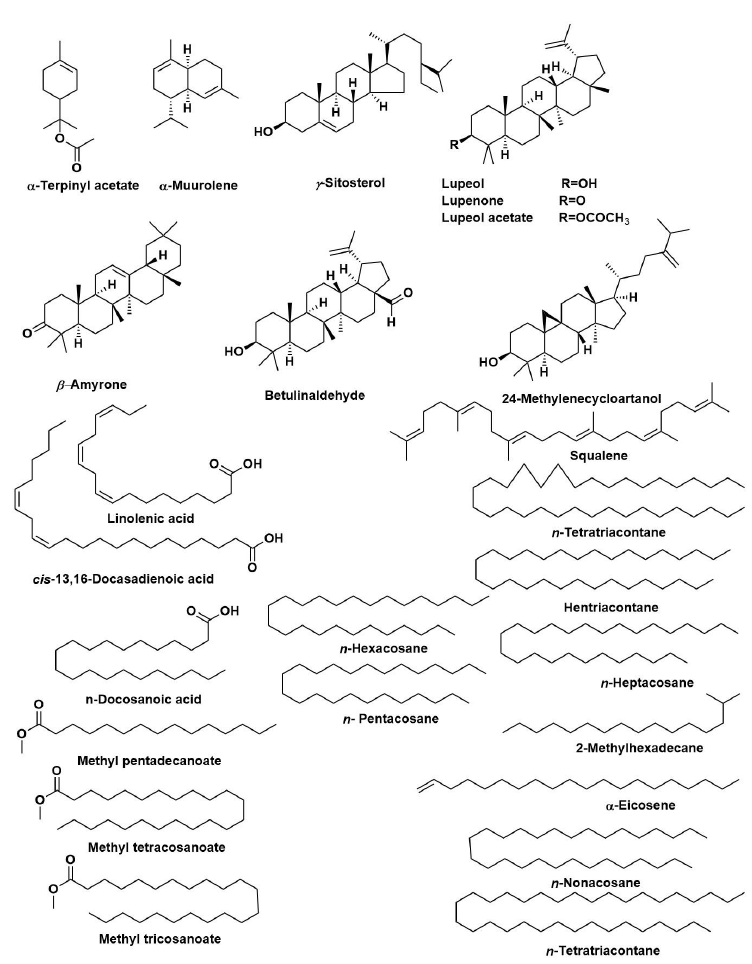
Figure 1. The major compounds identified in bark, leaves, seeds, and fruits of Tamarindus indica. Triterpenoids and steroids are the predominant classes in the T. indica bark n -hexane extract, accounting for 61.06 % and 13.47%, respectively. Additionally, the n -hexane ex- tract of T. indica leaves showed a high percentage of triterpenoids and steroids, represent- ing 47.41% and 11.86% of the identified compounds, respectively, along with fatty acids and their derivatives accounting for 8.40 %. On the other hand, the most predominant classes of metabolites in the n -hexane extract of T. indica seeds were fatty acids and their derivatives and the straight-chain hydrocarbons, accounting for 35.22% and 40.36%, re- spectively. Meanwhile, the straight-chain hydrocarbons were the dominant class in the n - hexane extract of T. indica fruits, representing 33.55% of the total identified compounds, followed by steroids and fatty acids and their derivatives, accounting for 12.67% and 11.55%, respectively. The illustration of the metabolite distribution in the various organs of T. indica is represented in (Figure 2).